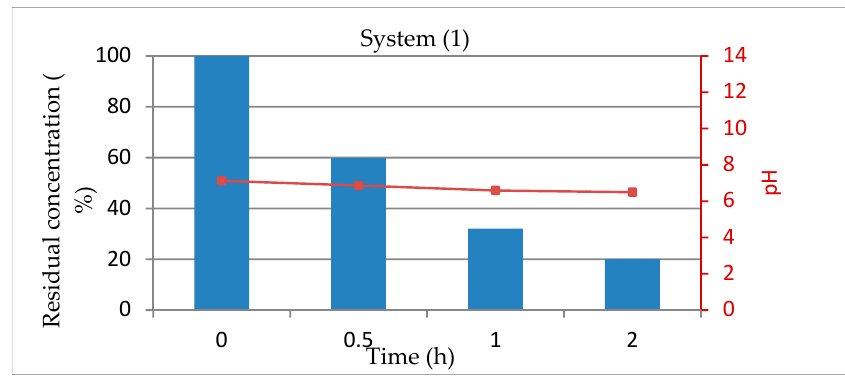
Figure 4. Residual concentration (%) and pH for System 1, as a function of the UV irradiation time exposure.